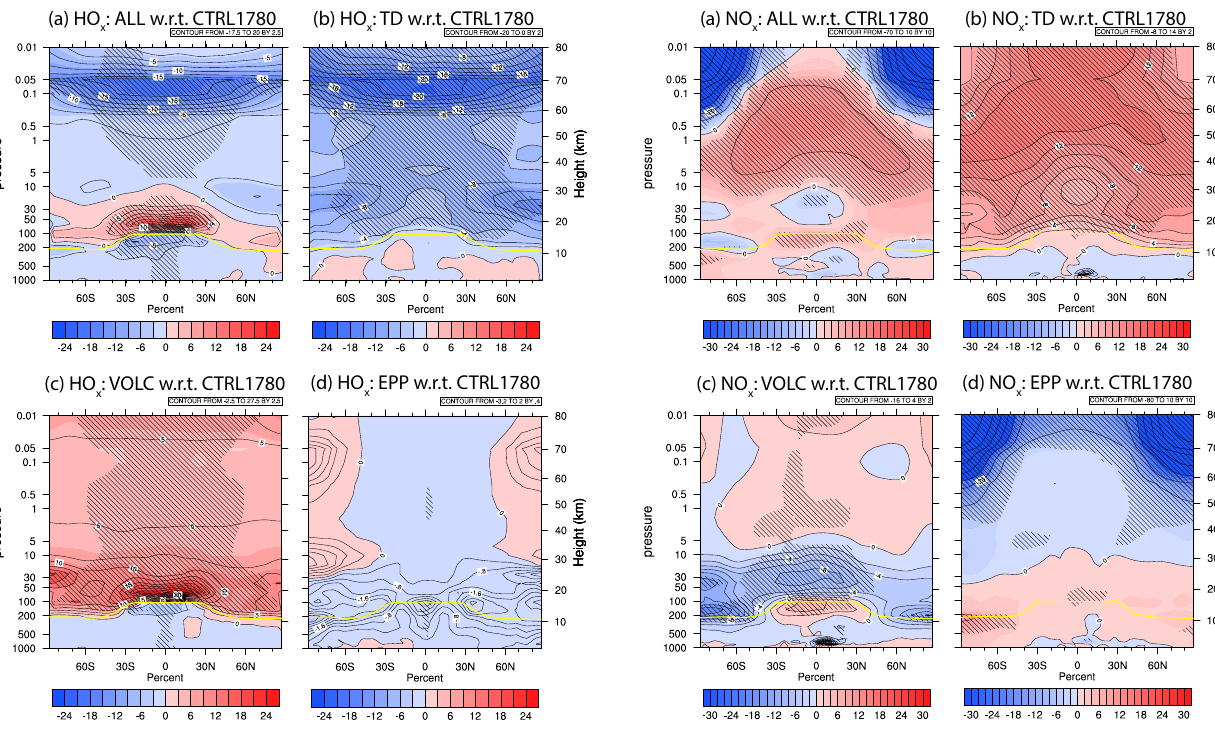
Fig. 4. Relative differences of yearly averaged HO x of the DM- ALL, DM-TD, DM-VOLC and DM-EPP experiments with relation to the DM-CTRL1780 forcing run. Hatched areas are significantly different on a Student’s t test with α = 5%. The yellow line illus- trates the height of the WMO tropopause.